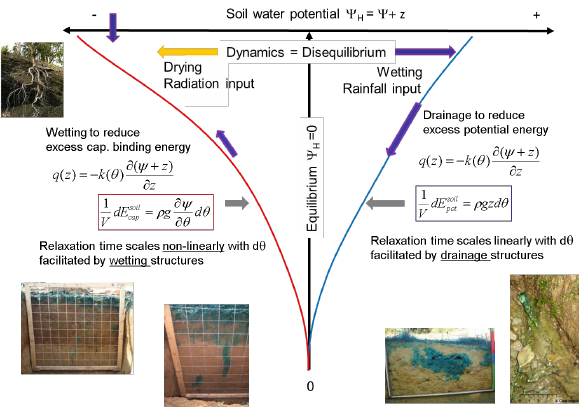
Fig. 2. Local thermodynamic equilibrium in soil as state of zero soil water potential. Drying causes deviations to negative values by increasing absolute values of negative capillary binding energy, wetting causes deviations to positive values by increasing potential energy of soil water. Note that the change in capillary binding energy per unit soil moisture change scales non-linearly with the slope of the soil water retention curve, which is a fingerprint of the pore size distribution in soil (compare Figure 3).